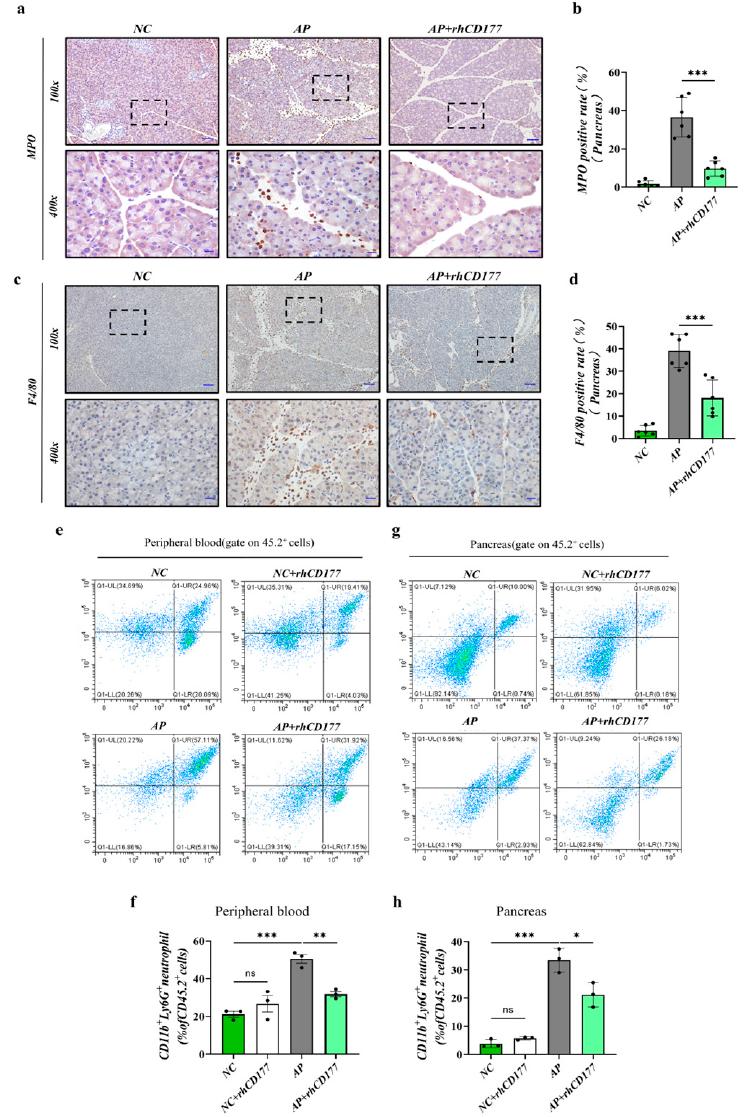
Figure 4. rhCD177 prevents the infiltration of immune cells in pancreatic tissues on AP mice. ( a ) Representative immunohistochemical images for MPO expression in the pancreas at magnifications 100 × and 400 × . Scale bar = 20 µ M. ( b ) Quantification of MPO-positive pancreatic acinar cells in each group ( n = 6 per group). ( c ) Representative immunohistochemical images for F4/80 expression in the pancreas at magnifications 100 × and 400 × . Scale bar =20 µ M. ( d ) Quantification of F4/80 positive pancreatic acinar cells in each group ( n = 6 per group). ( e , f ) Leukocytes from pancreatic tissue were isolated for staining and flow cytometry analysis. Representative flow cytometry gating of pancreatic neutrophils (CD45.2 + CD11b + Ly6G + ) is shown. ( g , h ) Percentages of CD11b + ly6G + neutrophils from pancreas are shown as scatter plots. Black dots represent samples. Data are presented as mean ± SEM ( n = 4 per group). Statistical significance is indicated by * p < 0.05, ** p < 0.01, *** p < 0.001.